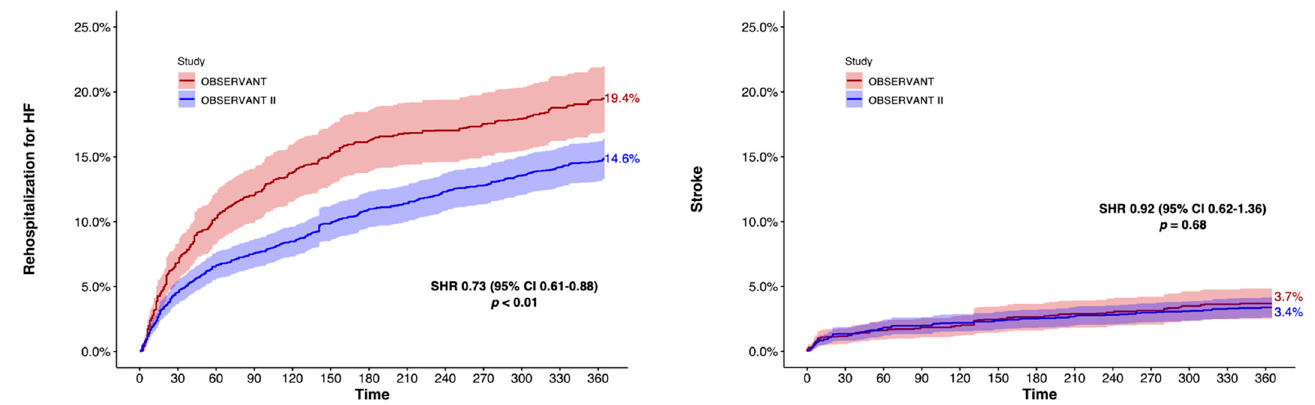
Figure 6. Adjusted 1-year Fine and Gray cumulative incidence analysis for rehospitalization for heart failure and stroke. CI, confidence interval; SHR, sub-distribution hazard ratio.